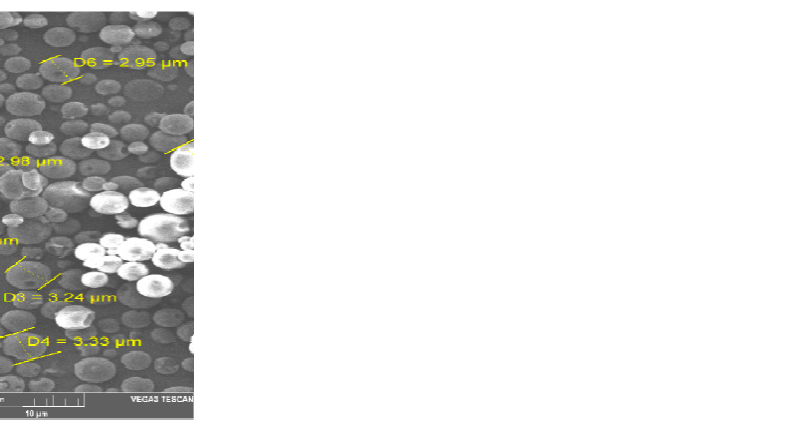
Table 2. Micromeritics properties of the free MXF and optimized MXF-PLGA-MS.